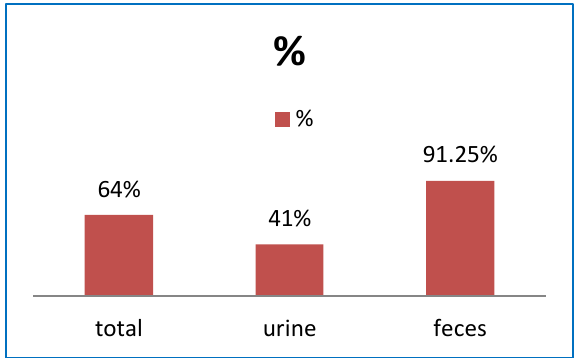
Figure, 3: The percentage of positive isolates of E.coli O157:H7 from feces and urine samples. Table, 1: Positive samples for E.coli 157:H7 in feces